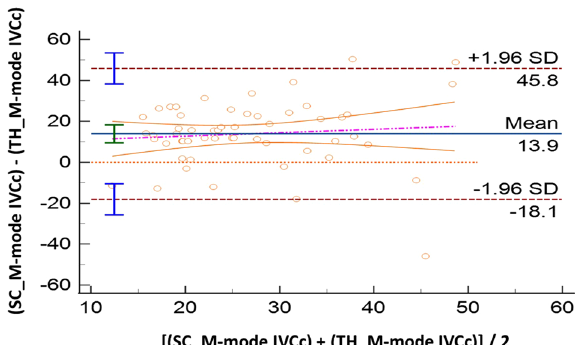
Fig. 3 Bland–Altman plot for the inferior vena cava collapsibility index (IVCc) measured with standard M-mode in two different sites: subcostal (SC) and transhepatic (TH). SD: standard deviation